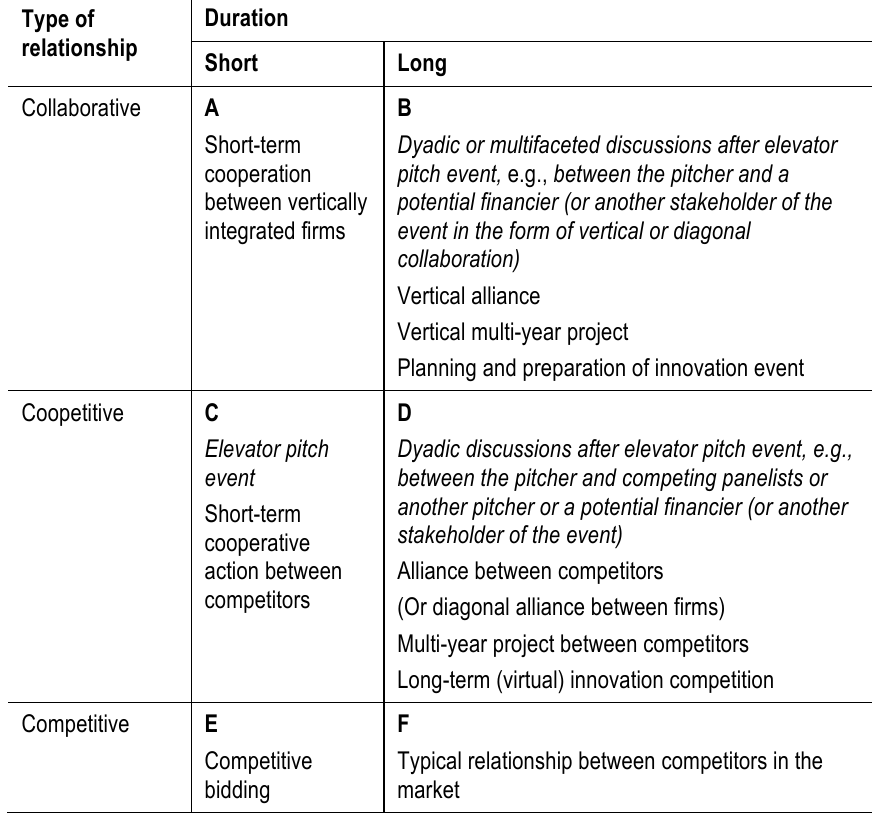
Table 3. Elevator pitch event among the dimensions of duration and different types of